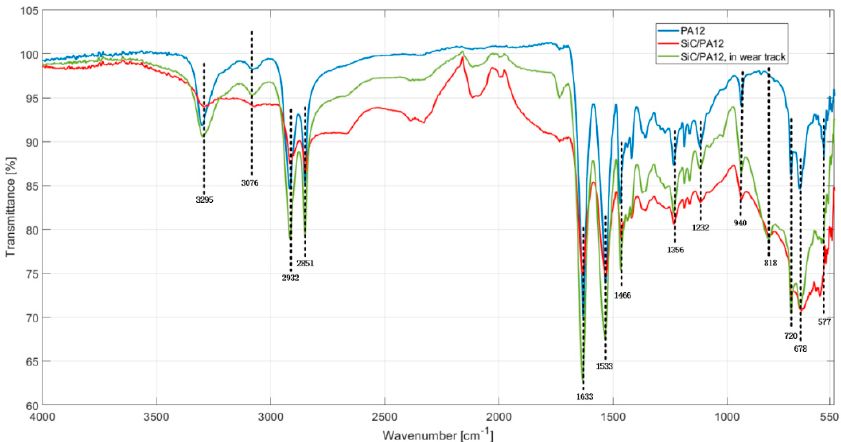
Figure 10. FTIR spectra of the surface and wear track of the sample.